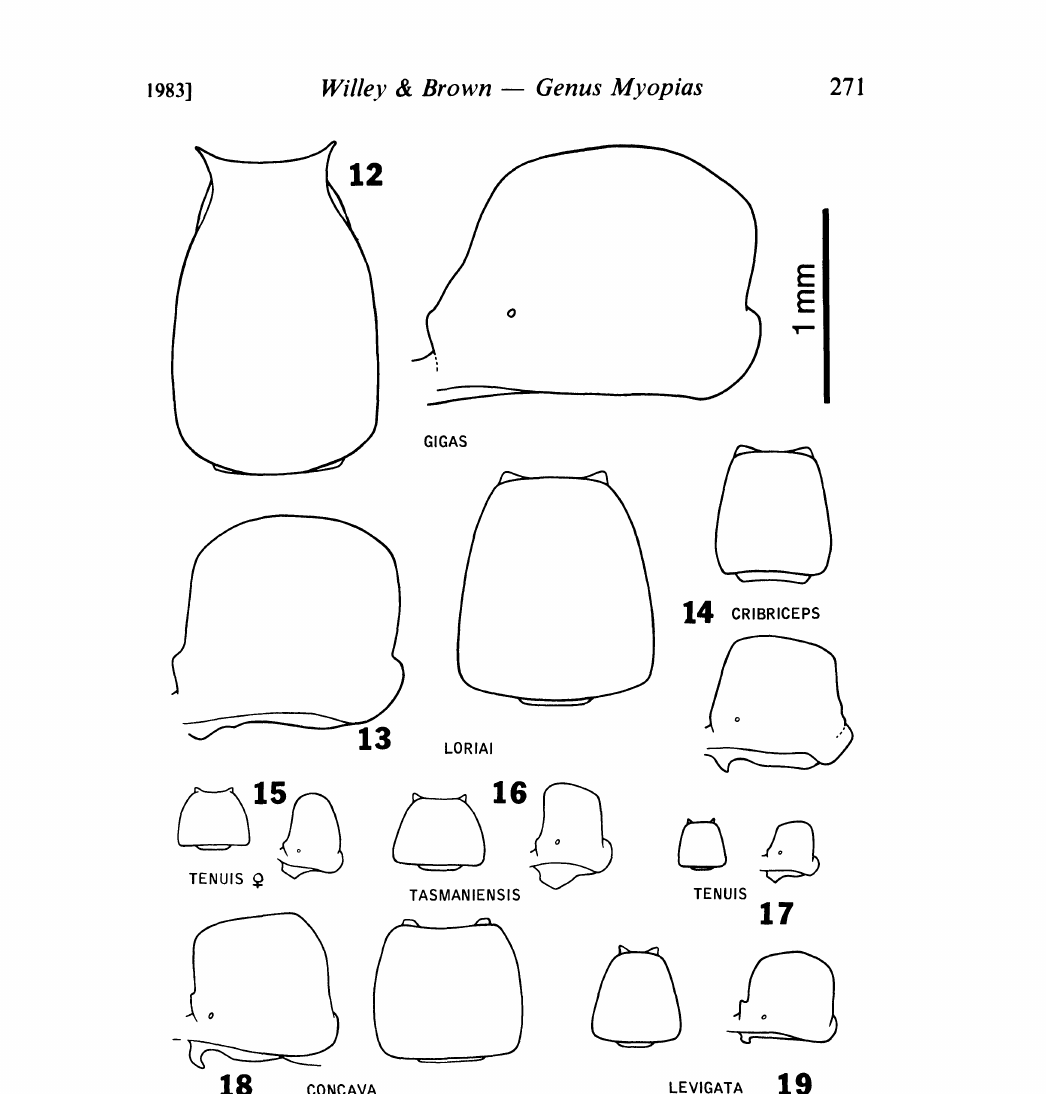
Figs. 12-19, Myopias spp., petiolar nodes in lateral and dorsal view, sculpture and pilosity omitted, all to same scale. Fig. 12, M. gigas holotype worker. Fig. 13, M. Ioriai worker fro Gemeheng, Huon Peninsula, Papua New Guinea. Fig. 14, M. cribriceps worker from Bubia, near Lae, Papua New Guinea. Fig. 15, M. tenuis queen from Bubia, near Lae, Papua New Guinea. Fig. 16, M. tasmaniensis from Olinda, Victoria, Australia. Fig. 17, M. tenuis worker from Bubia, near Lae, Papua New Guinea. Fig. 18, M. concava paratype worker from lower Busu R., near Lae, Papua New Guinea. Fig. 19, M. levigata worker from Nganduo, Huon Peninsula, Papua New